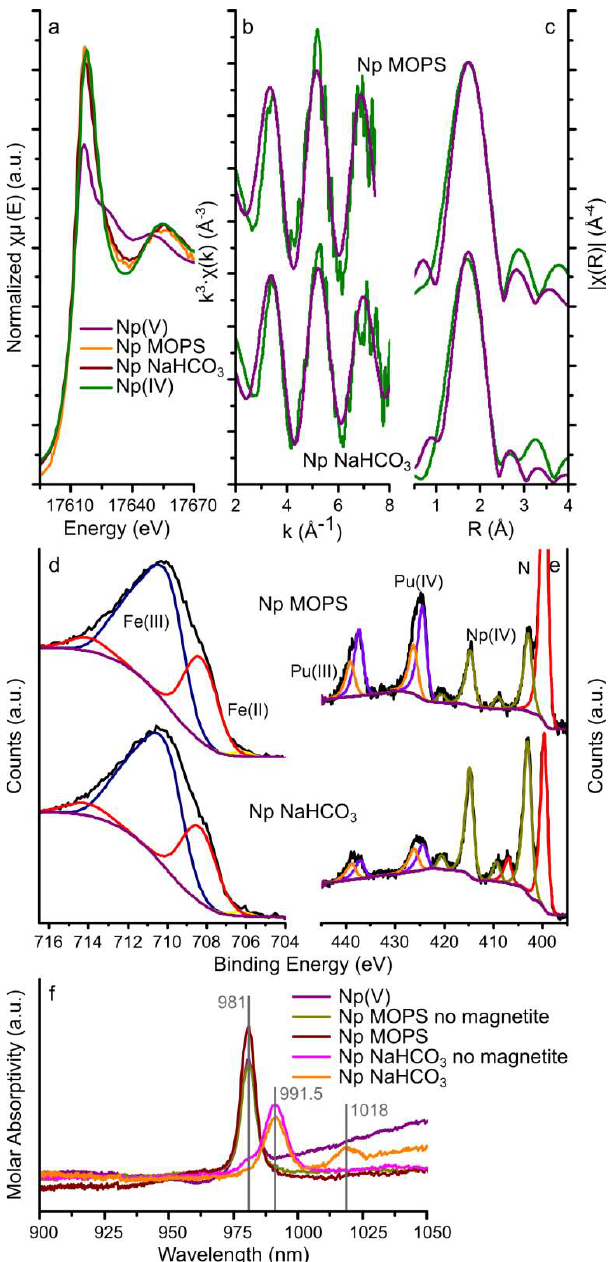
Figure 3. Neptunium L III -edge GI-XAS, XPS, and UV-Vis spectroscopy data. Neptunium L III -edge XAS results: (a) XANES with aqueous Np(IV) and Np(V) standards [64] ; and (b and c) EXAFS (green lines) and corresponding fits (purple lines) to the Np MOPS and Np NaHCO 3 samples; XPS data for the iron 2p 3/2 transition (d) , and neptunium (and plutonium) 4f 7/2 and 5/2 transitions (e) (black lines) and fits to the spectra (coloured lines, blue and purple lines represent Fe(III) and Fe(II), respectively, the purple and orange lines represent Pu(IV) and Pu(III), respectively, and the olive lines represent Np(IV) for the Np MOPS and Np NaHCO 3 samples, in the iron 2p 3/2 plot (d) , in the iron 2p 3/2 plot (d) , the fitted Fe(II) and Fe(III) peaks have been merged for clarity; and (f) the UV-Vis spectra for a pH 4 NpO 2+ (Np(V)) solution (prepared by diluting the stock solution in DI water only), two solutions with 10 ppm neptunium and 10 mM MOPS (Np MOPS no magnetite) or 5 mM NaHCO 3 (Np NaHCO 3 no magnetite) and the aqueous phase after 14 days equilibration with magnetite (Np MOPS and Np NaHCO 3 ), the vertical grey lines represent the absorption bands observed in the spectra.